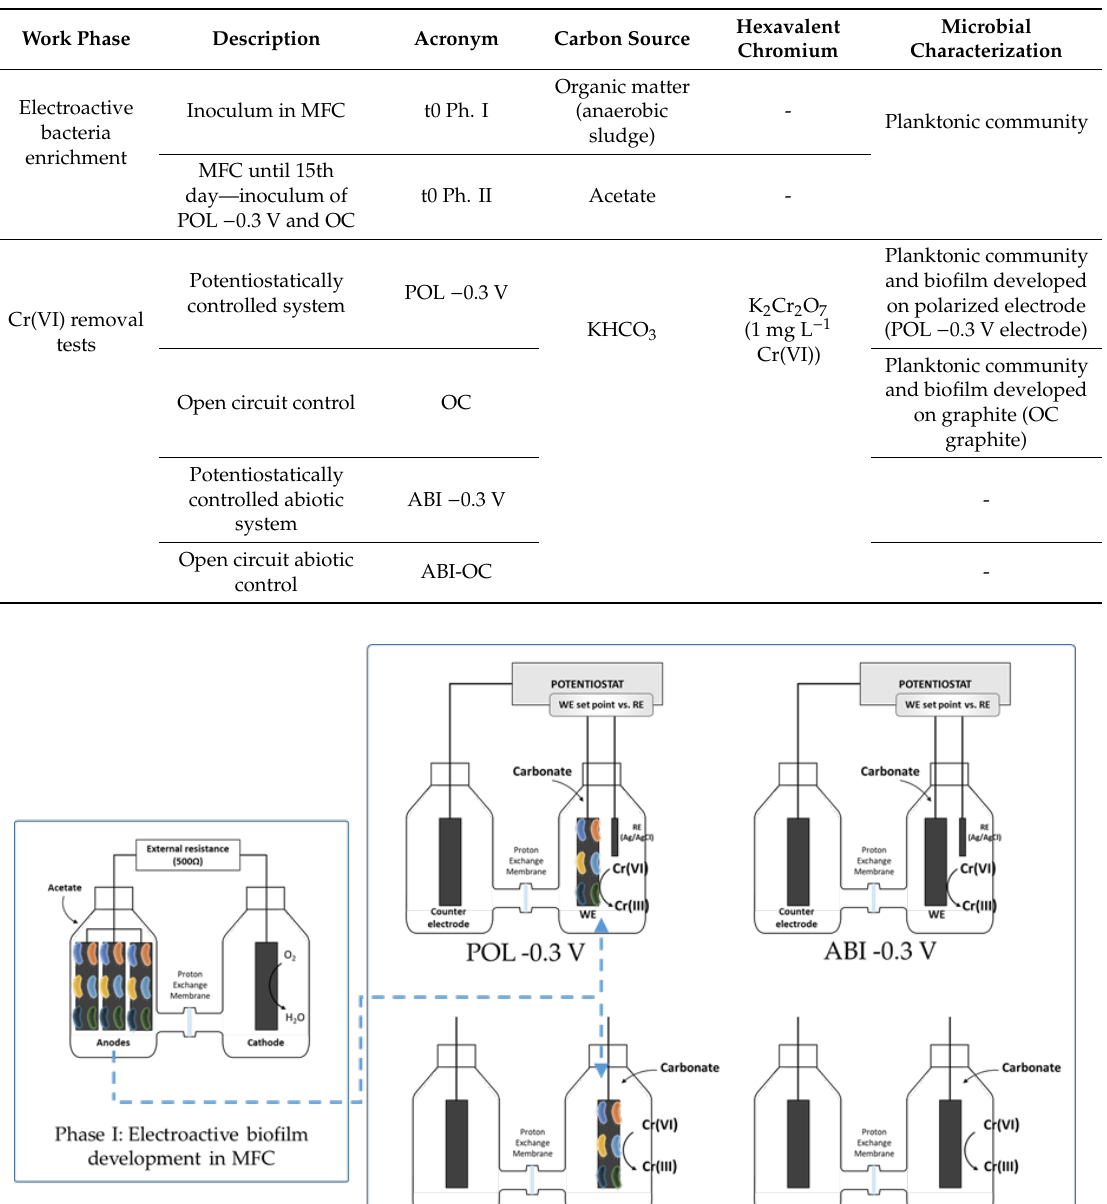
Table 1. Summary table of the experimental work.